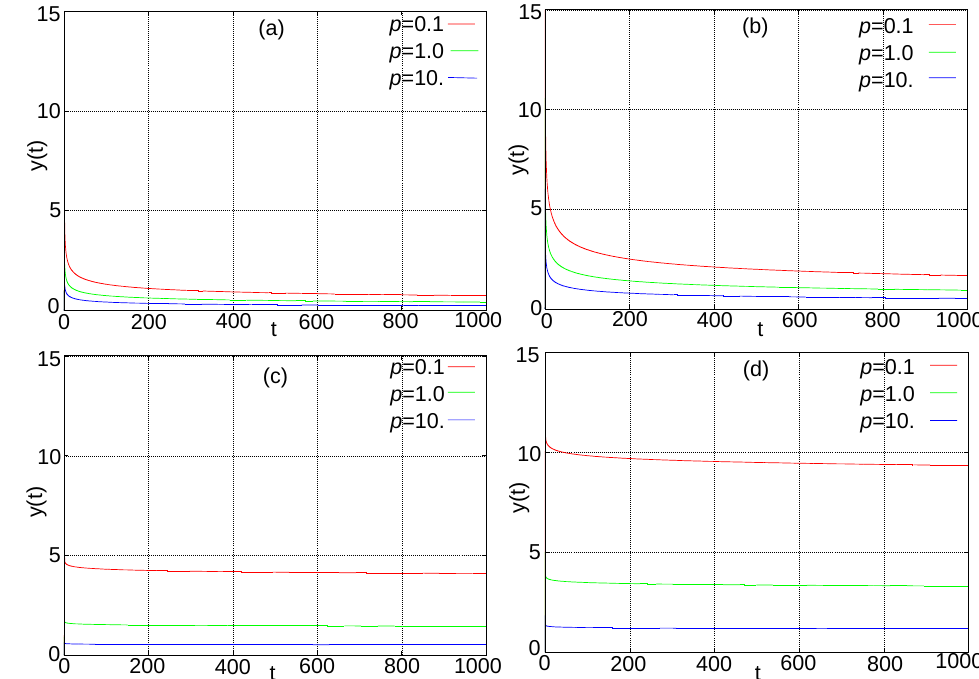
Figure 5. Simulation results for model (30) without the influence of a random process. The α - quenching by energy ( γ = 1). The parameter p values are shown on the legends. The parameter D and β values on panels: ( a ) D = 20, β = 0.5; ( b ) D = 100, β = 0.5; ( c ) D = 20, β = 0.9; ( d ) D = 100, β =